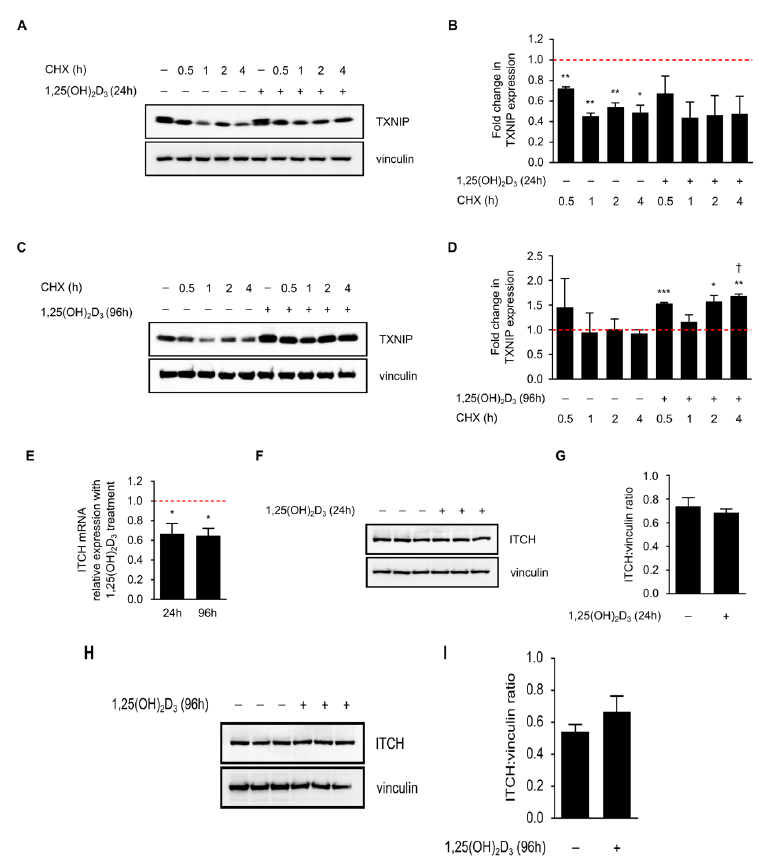
Figure 4. Cycloheximide (CHX) reduces TXNIP half-life in 24, but not in 96 h 1,25(OH) 2 D 3 -treated HL-60 cells. ( A ) Inhibition of protein synthesis by CHX (10 µ M) treatment, added into the conditioned medium of DMSO- and 1,25(OH) 2 D 3 -treated HL-60 cells, at different time intervals prior to the end of the initial treatment period (24 h), led to reduced TXNIP protein levels in the presence and absence of 1,25(OH) 2 D 3 . “+” and “ − ” denote the presence or absence of the indicated molecule/treatment, respectively; ( B ) Densitometric quantification of two similar biological replicates. The dashed red line indicates baseline TXNIP protein expression in DMSO-treated cells set to 1; ( C ) In 96 h-treated HL-60 cells, CHX reduced or had no effect on TXNIP protein levels in absence or presence of 1,25(OH) 2 D 3 , respectively; ( D ) Densitometric quantification of 2 similar biological replicates. Statistical comparisons made between the different conditions and DMSO-treated cells were performed using a two-tailed Student’s t -test. p -Values less than or equal to 0.05, 0.01, and 0.001, are depicted by *, **, and ***, respectively. A dagger indicates statistical significance compared to the corresponding mono-treatment. Error bars ± SEM; ( E ) ITCH mRNA expression analysis in response to 24 and 96 h of treatment with 1,25(OH) 2 D 3 . The dashed red line indicates baseline ITCH mRNA level in DMSO-treated cells set to 1. Error bars ± SD; n = 2; ( F , G , H , I ) Analysis of ITCH protein levels after a ( F , G ) 24 h or ( H , I ) 96 h treatment with 1,25(OH) 2 D 3 ; ( G , I ) Densitometric quantifications illustrate only mild differences in response to